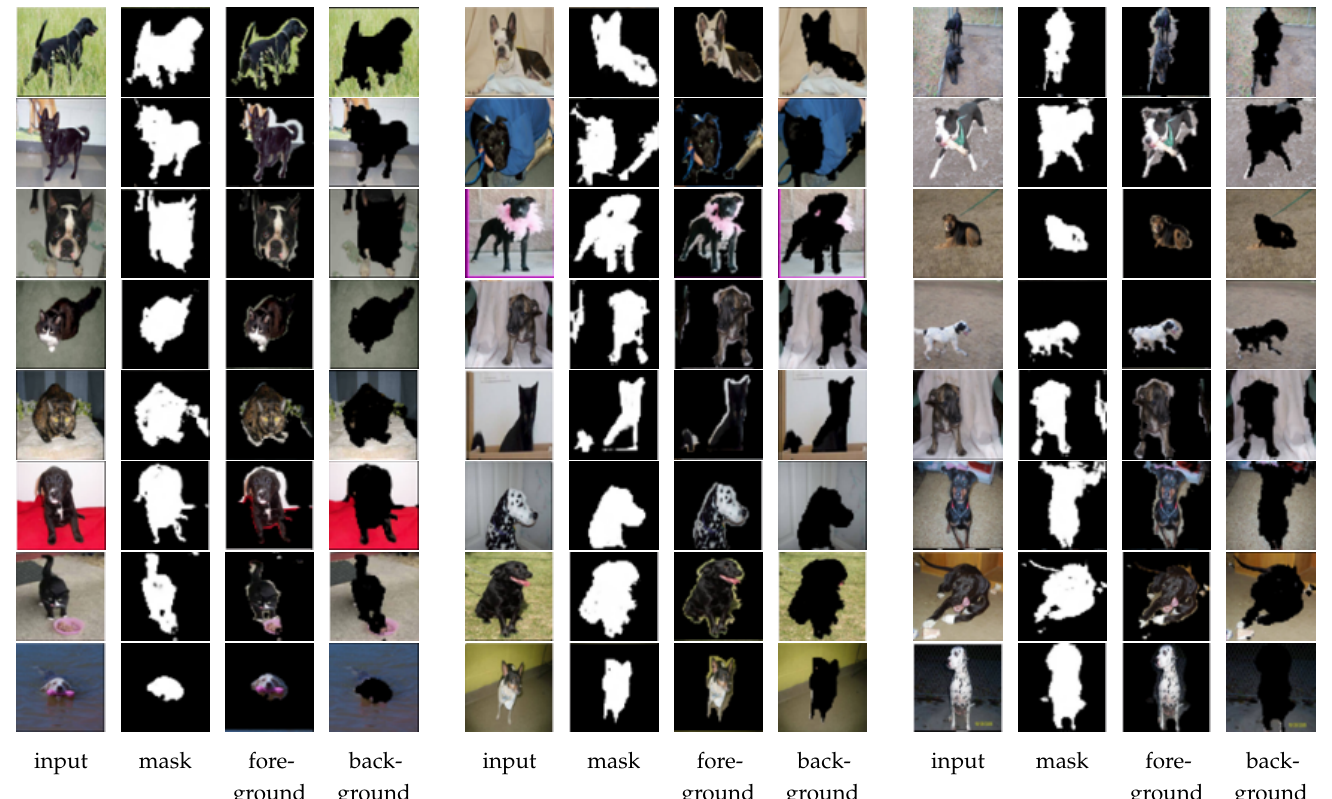
Figure 5. The result of the Mumford–Shah network with ResNet-18 as a classifier.